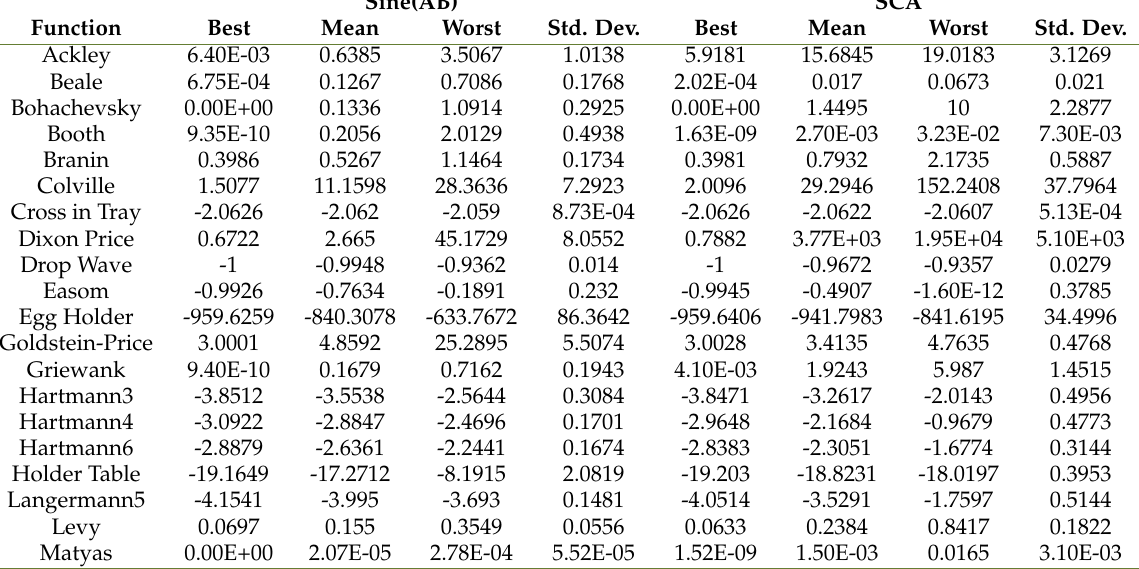
Table 4. Results of a = 1 (2 for SCA)